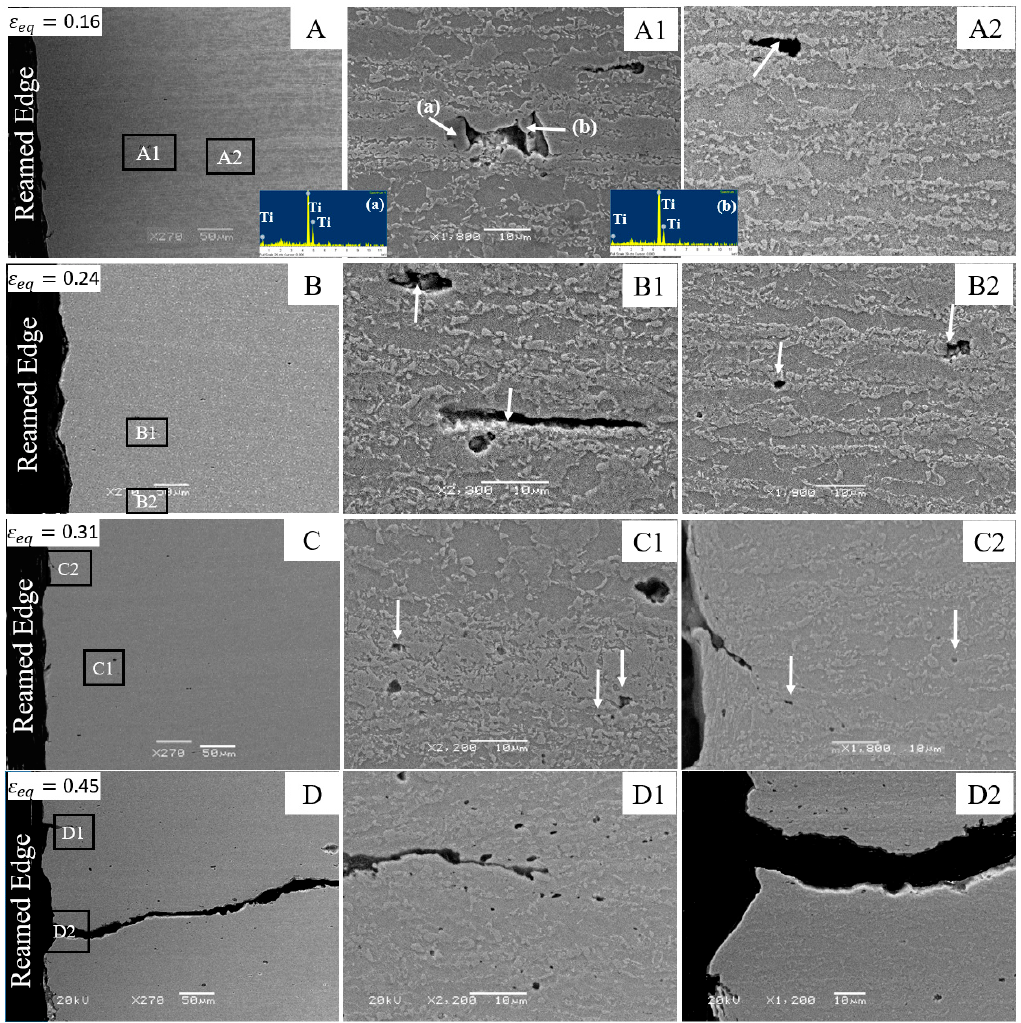
Figure 11. SEM micrographs of the interrupted DP780 reamed edge hole tension specimens at different strain levels: ( A ) 0.16; ( B ) 0.24; ( C ) 0.31; and ( D ) 0.45.